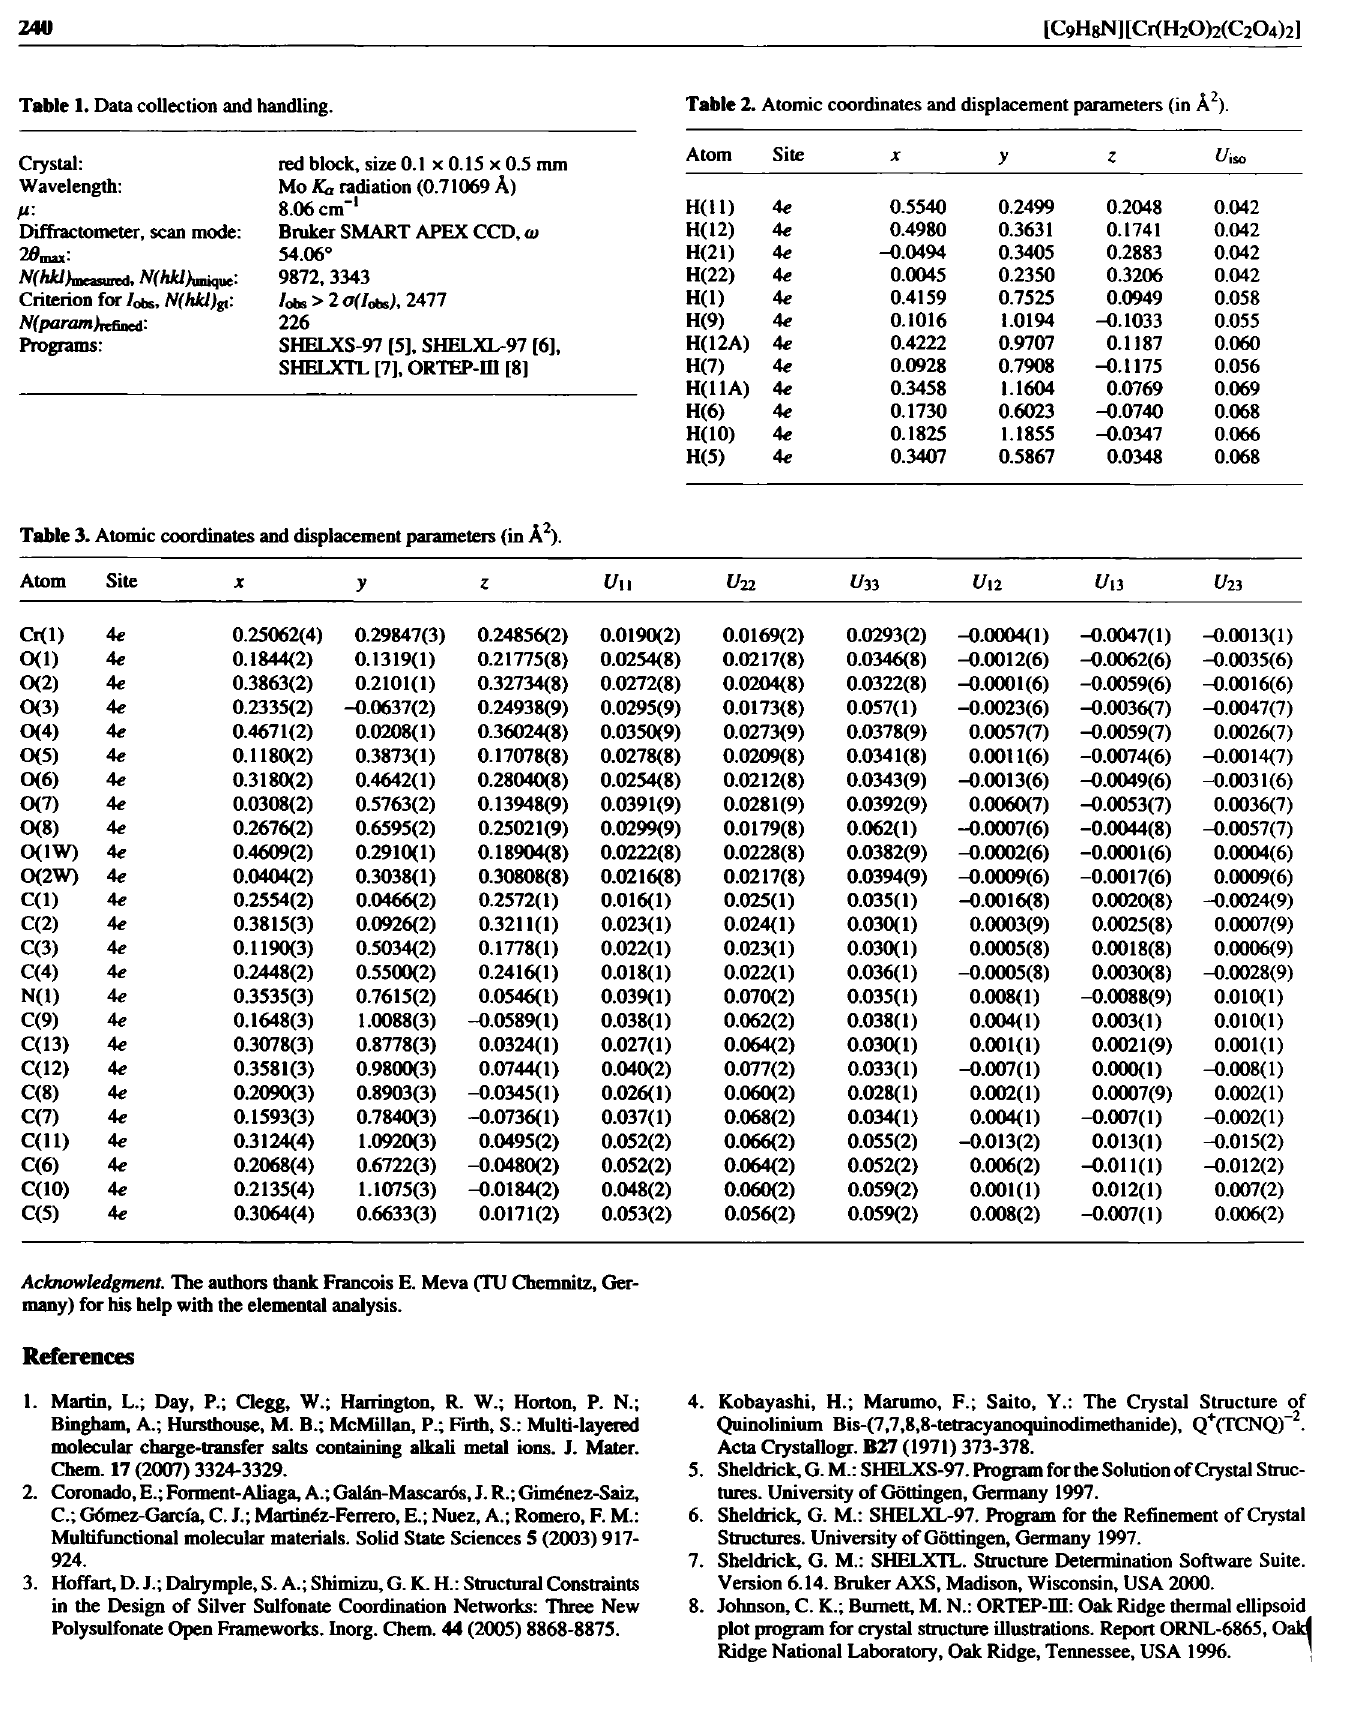
Table 1. Data collection and handling. Table 2. Atomic coordinates and displacement parameters (in Â 2 ).